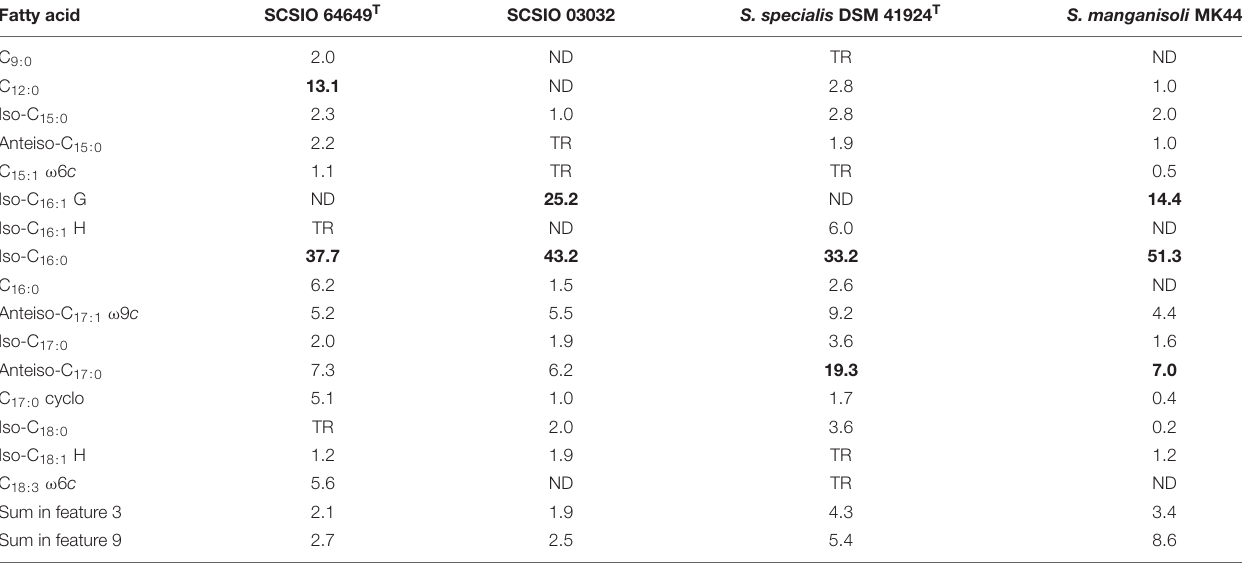
All strains are positive for hydrolysis of starch and Tweens 40 and 80 but negative for nitrate reduction, H 2 S production, milk coagulation, and peptonization. All data come from this study (except data marked with *). + , positive; –, negative. *Data from Mo et al. (2018). TABLE 3 | Cellular fatty acid profiles of strain SCSIO 64649 T and its neighbors in genus Streptomyces